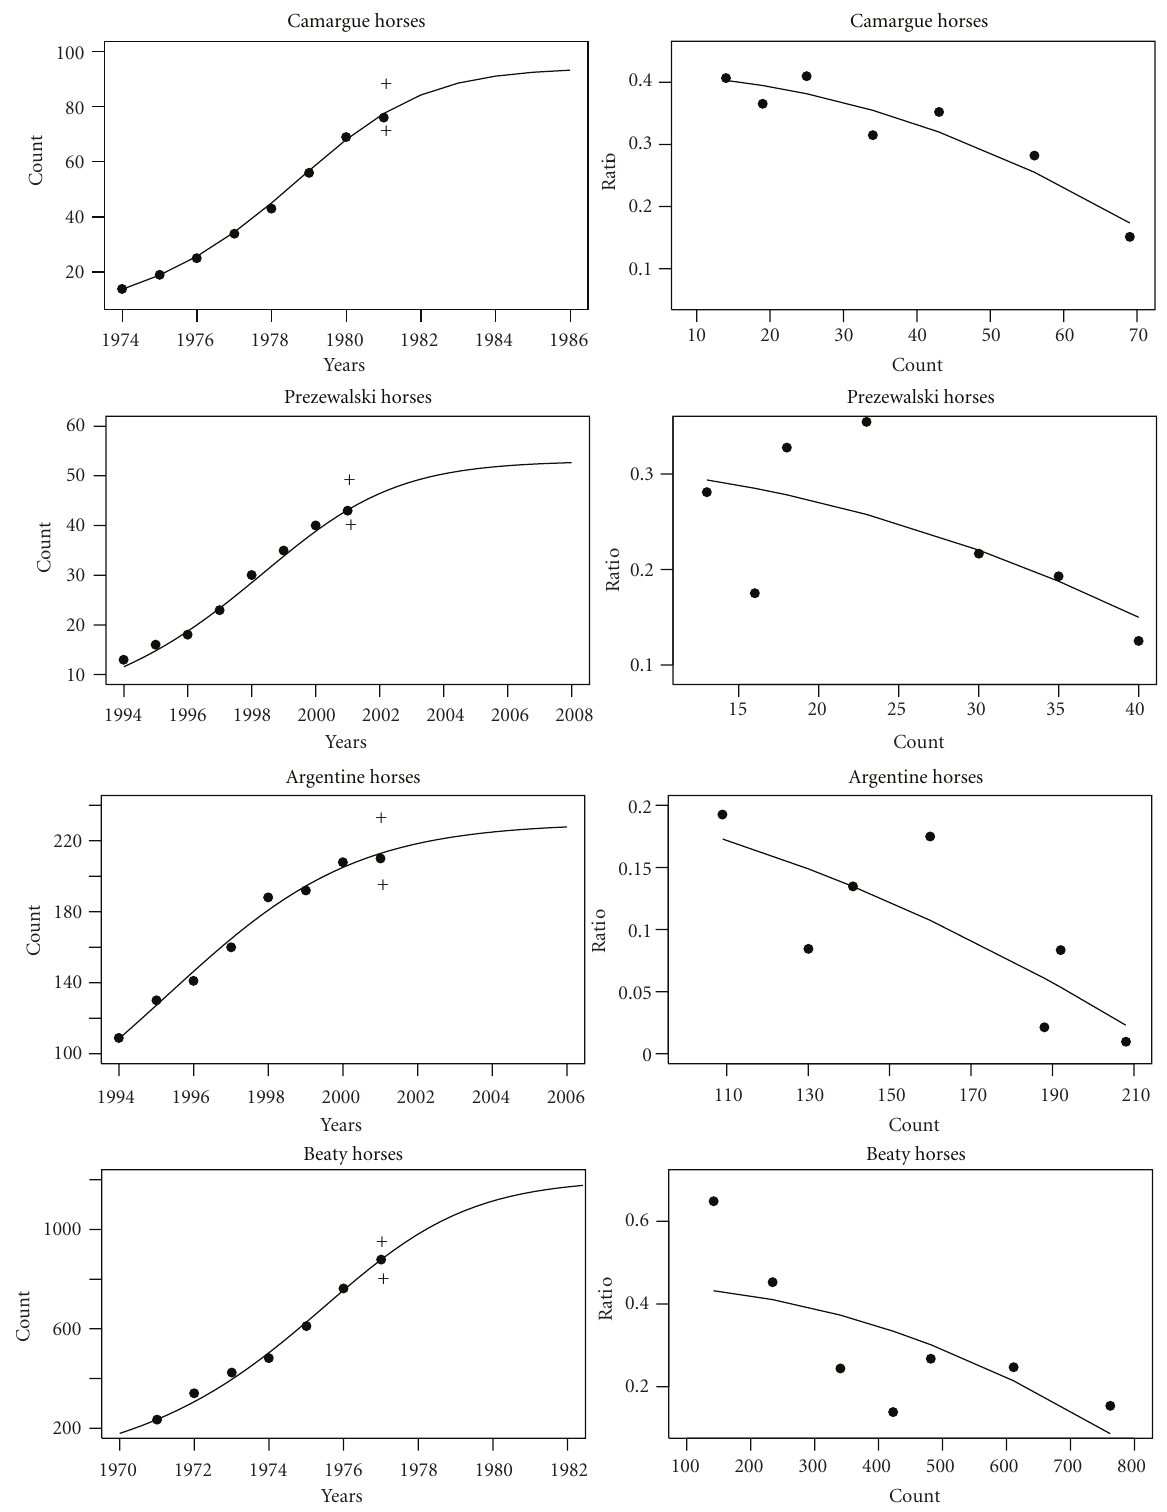
Figure 1: Left-hand panel: fits of the modified logistic curve (3) with 95% confidence limits derived from (4); right-hand panel: fits of the Sibly model (7) to the same